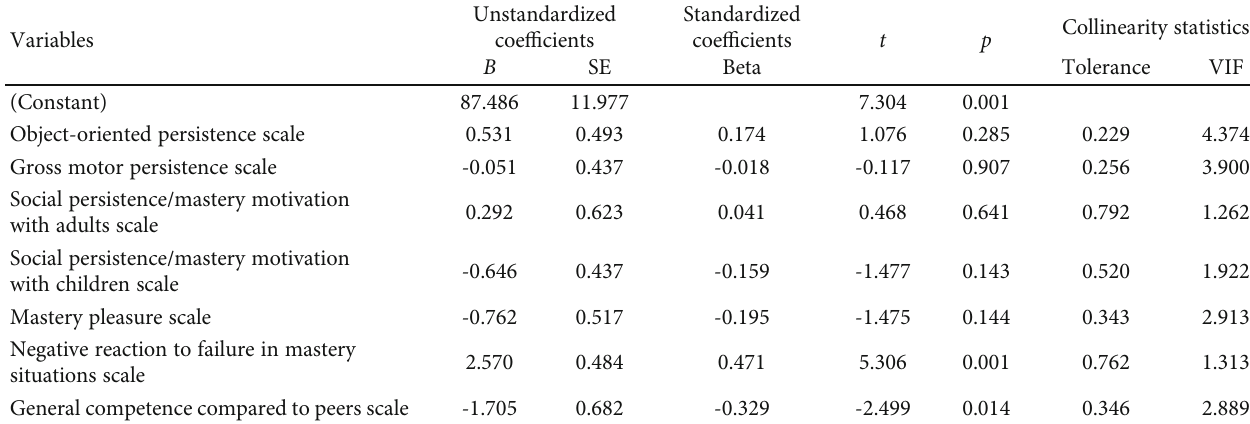
Table 5: Mastery motivation to predict sensory processing ( N = 99